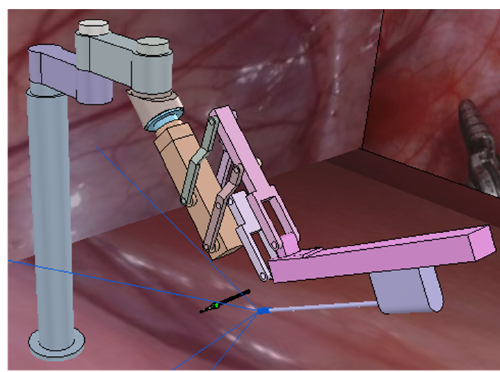
Figure 9. The real surgical image as the background.